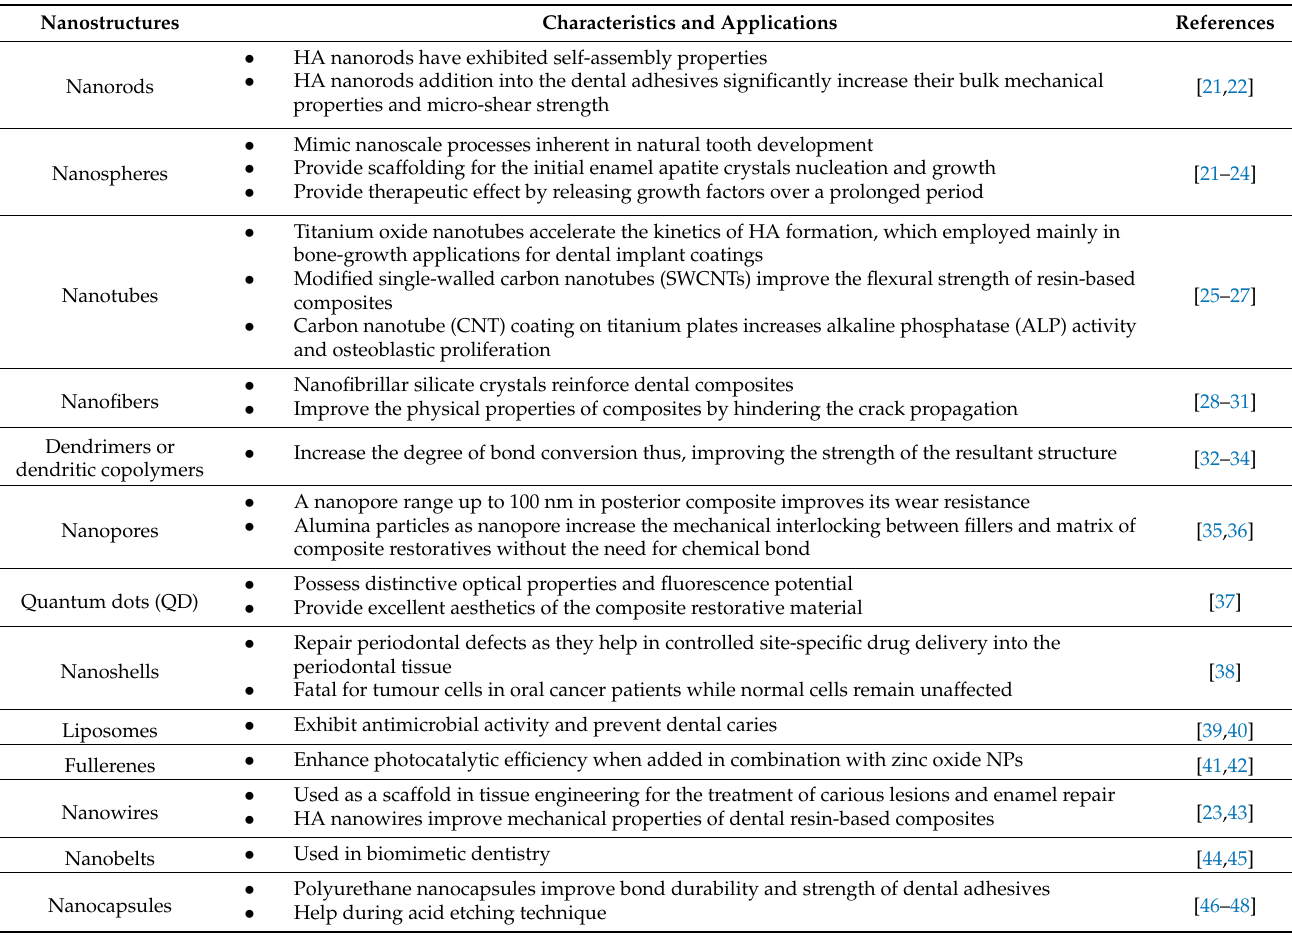
Table 1. Brief Overview of Nanostructures and their Dental